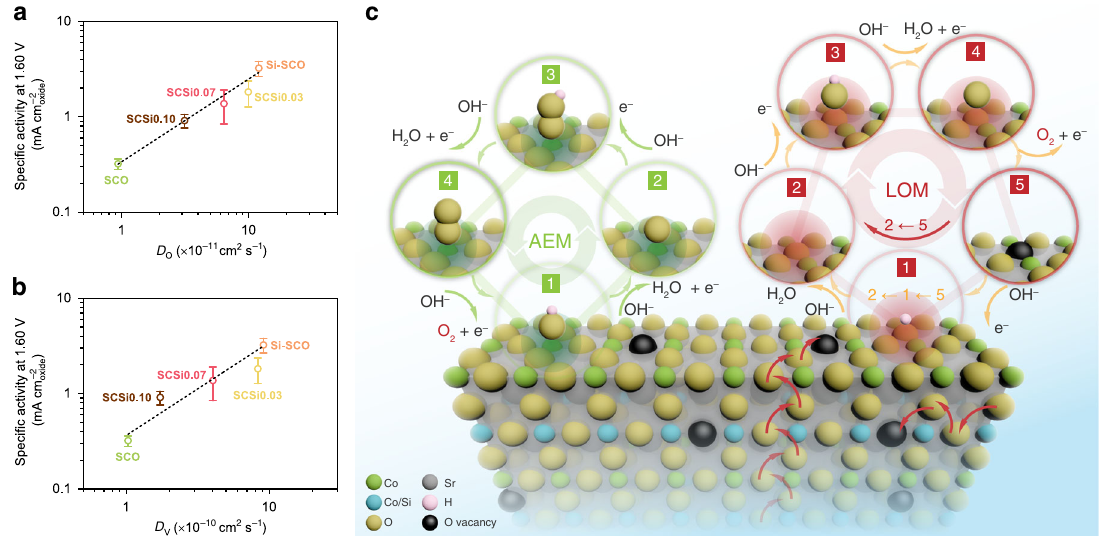
Fig. 5 Activity correlations and lattice oxygen participation in the OER on Si-incorporated strontium cobaltites. a Correlation of intrinsic OER activity in 0.1 M KOH with the oxygen anion diffusion rate. b Correlation of intrinsic OER activity in 0.1 M KOH with the oxygen vacancy diffusion rate. c A schematic illustration of the AEM and LOM reaction pathways on Si-incorporated strontium cobaltites. The AEM occurs via concerted proton-coupled electron- transfer steps on the transition metal site, while the LOM operates via non-concerted proton – electron transfer steps involving the participation of lattice oxygen. The mobility of lattice oxygen is also illustrated to highlight its important role in enhancing lattice oxygen